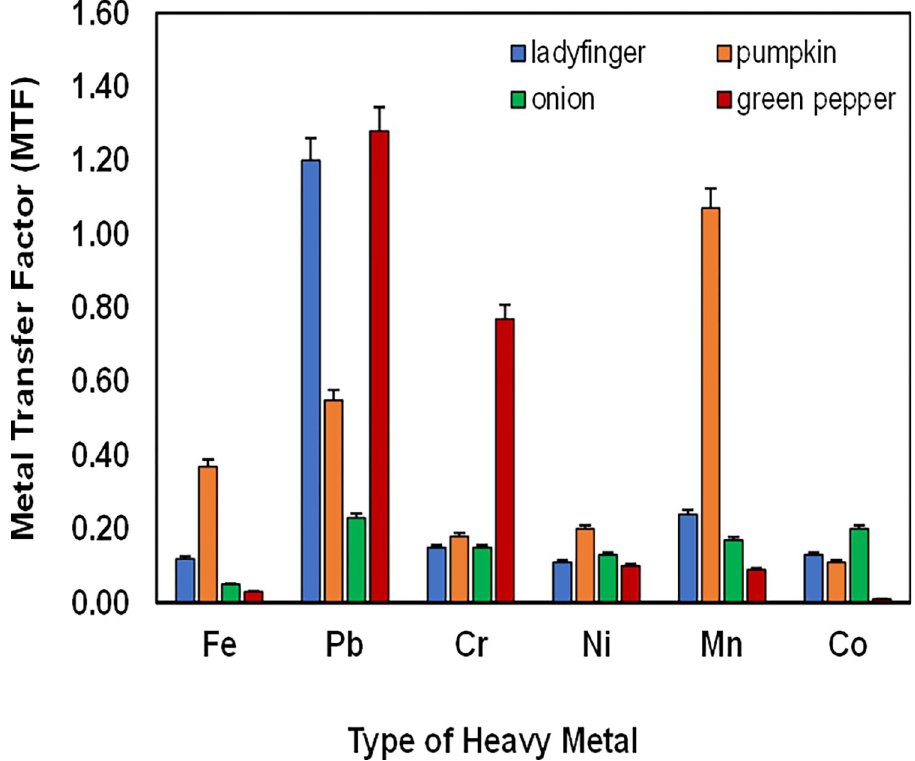
Fig 1. MTF of Fe, Pb, Cr, Ni, Mn, and Co from soil into vegetables. MTF is calculated from the mean values of three samples of each heavy metal.